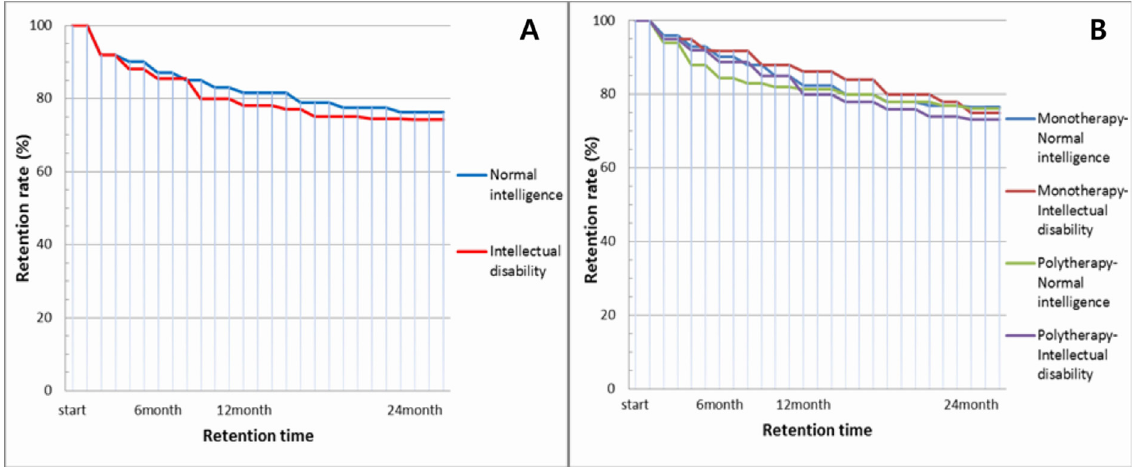
Figure 2. Retention rates at 6, 12, and 24 months after treatment with levetiracetam. ( A ) Patients with normal intelligence and intellectual disability. ( p = 0.612). ( B ) Patients with normal intelligence and intellectual disability in monotherapy and polytherapy ( p = 0.511).